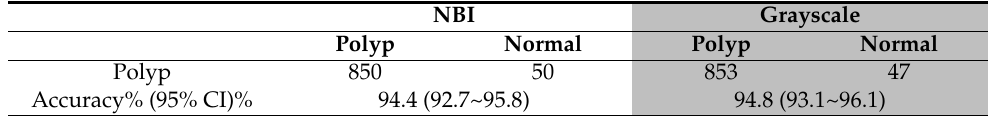
Table 8. CGMH-NBI testing dataset of polyp detection.